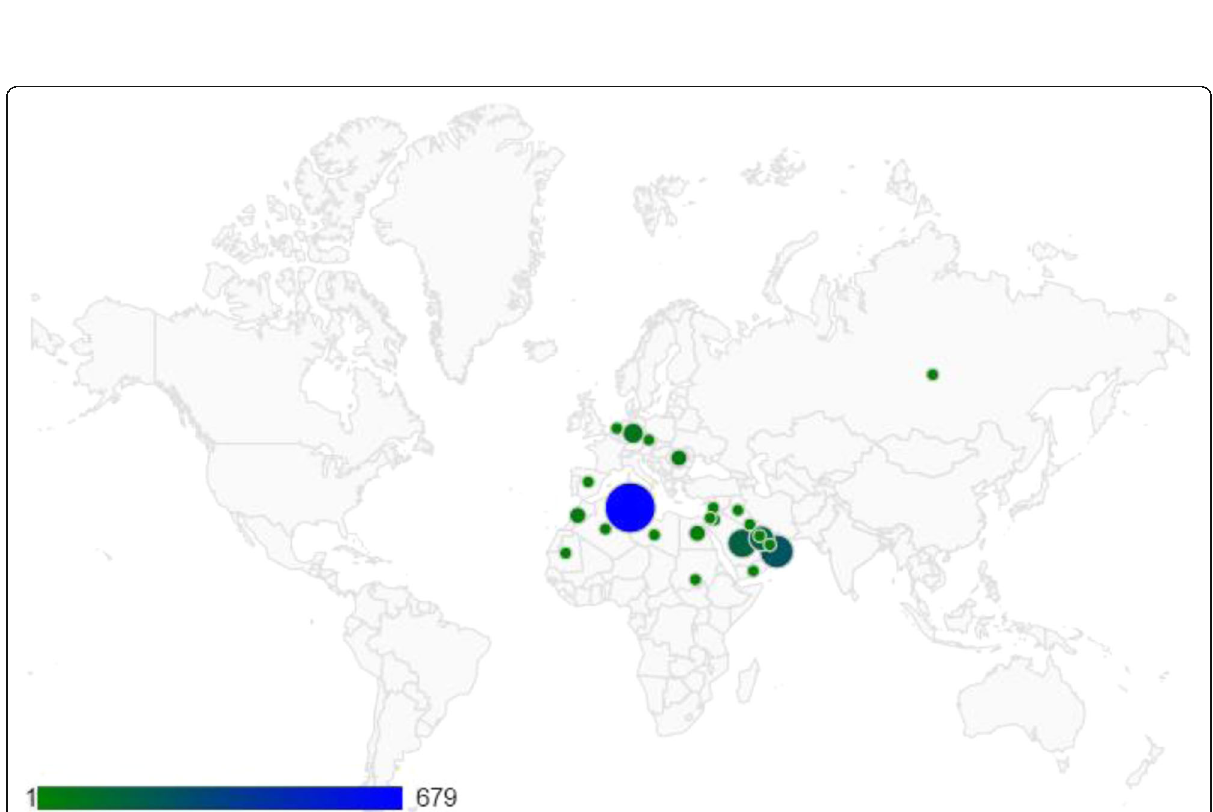
Fig. 15 ALECSO APPs Editor user ’ s distribution